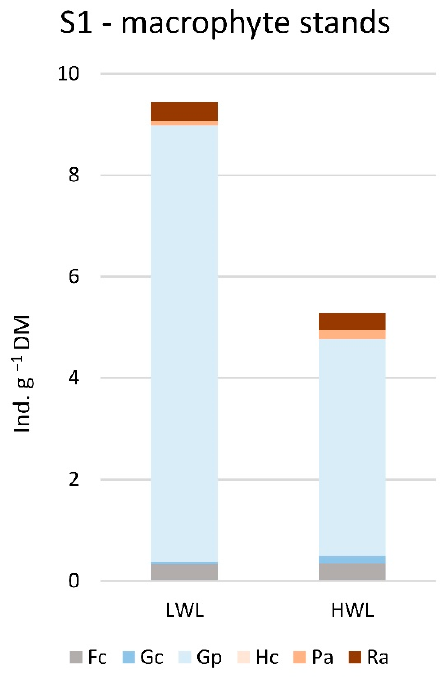
Figure 3. Gastropod abundance within the macrophyte stands of S1. Abbreviations of species names are given in Materials and Methods.